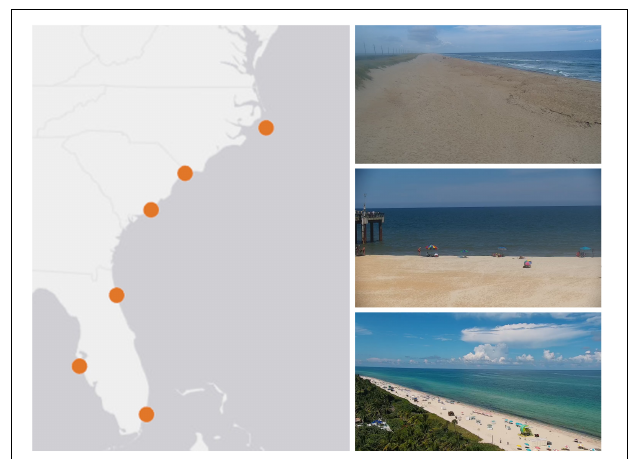
FIGURE 1 | The six pilot WebCAT webcam locations (left) and example snapshots from the webcams in Buxton, NC (top right), St. Augustine Pier, FL (middle right) and Miami, FL (bottom right). The other webcam locations (not shown) include North Myrtle Beach, SC, Folly Beach, SC, and Bradenton, FL.